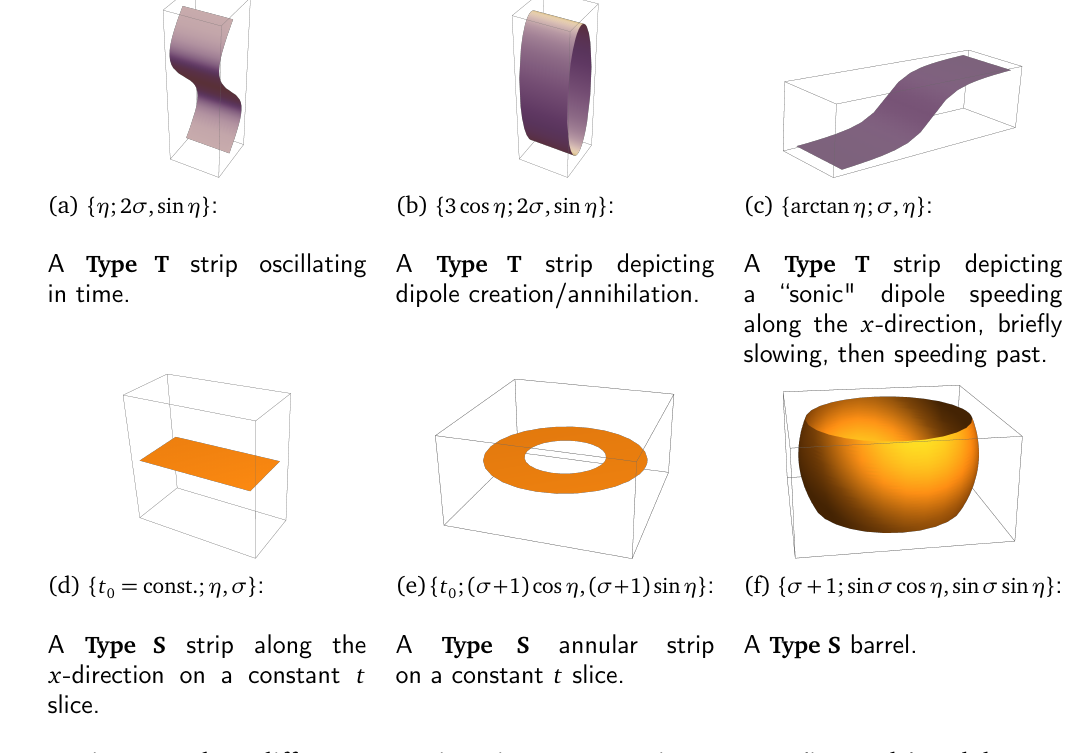
Figure 2: Three different gauge-invariant Type T strip operators (in purple) and three different gauge-invariant Type S strip operators (in orange). Time runs upward in these figures. The parameterizations generating the figures are provided in the form { ¯ t ; ¯ x i } . It is easy to verify each parameterization matches either Type T or Type S in (73) and satisfies the orthogonality constraint, (71).